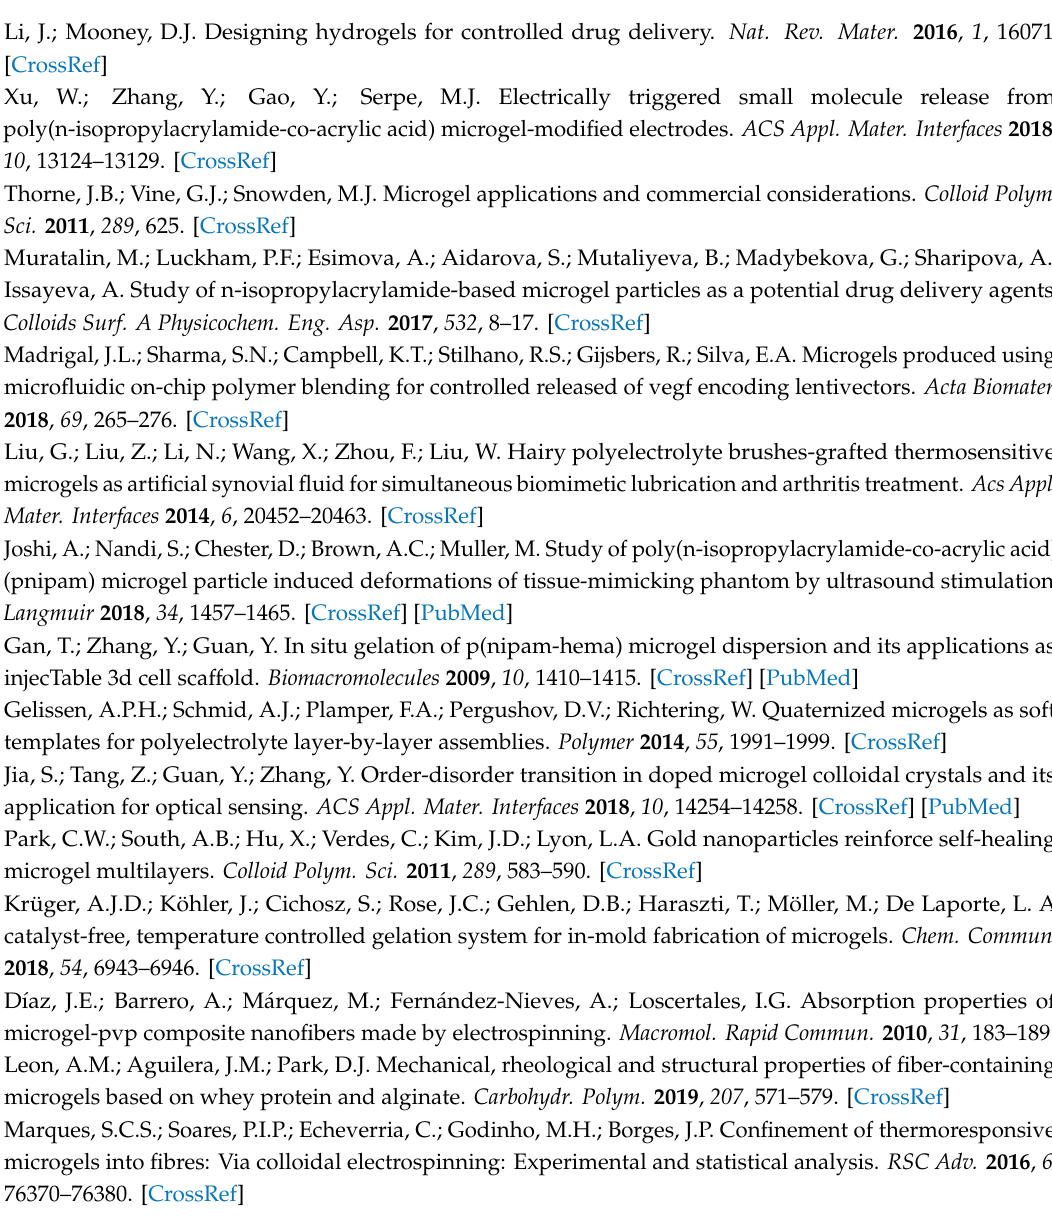
Figure S1: (a) 1 H-NMR spectrum corresponding to P(NIPAM- co -DMAEMA25), P(NIPAM- co -DMAEMA25-QMe) and P(NIPAM- co -DMAEMA25-QBu). (b) P(NIPAM- co -DMAEMA) microgel quaternization reaction; Figure S2: DSC thermorgrams during second heating scan of (a) P(NIPAM- co -DMAEMA) (b) P(NIPAM- co -DMAEMA-QMe) and P(NIPAM- co